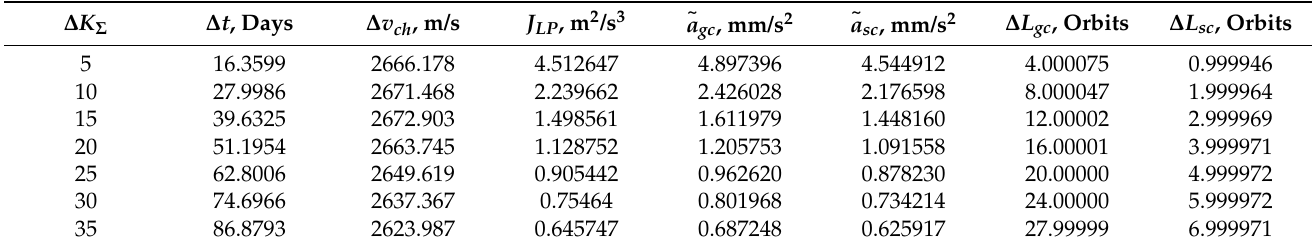
Table 2. The main parameters of the optimal trajectories with an intermediate EM L 1